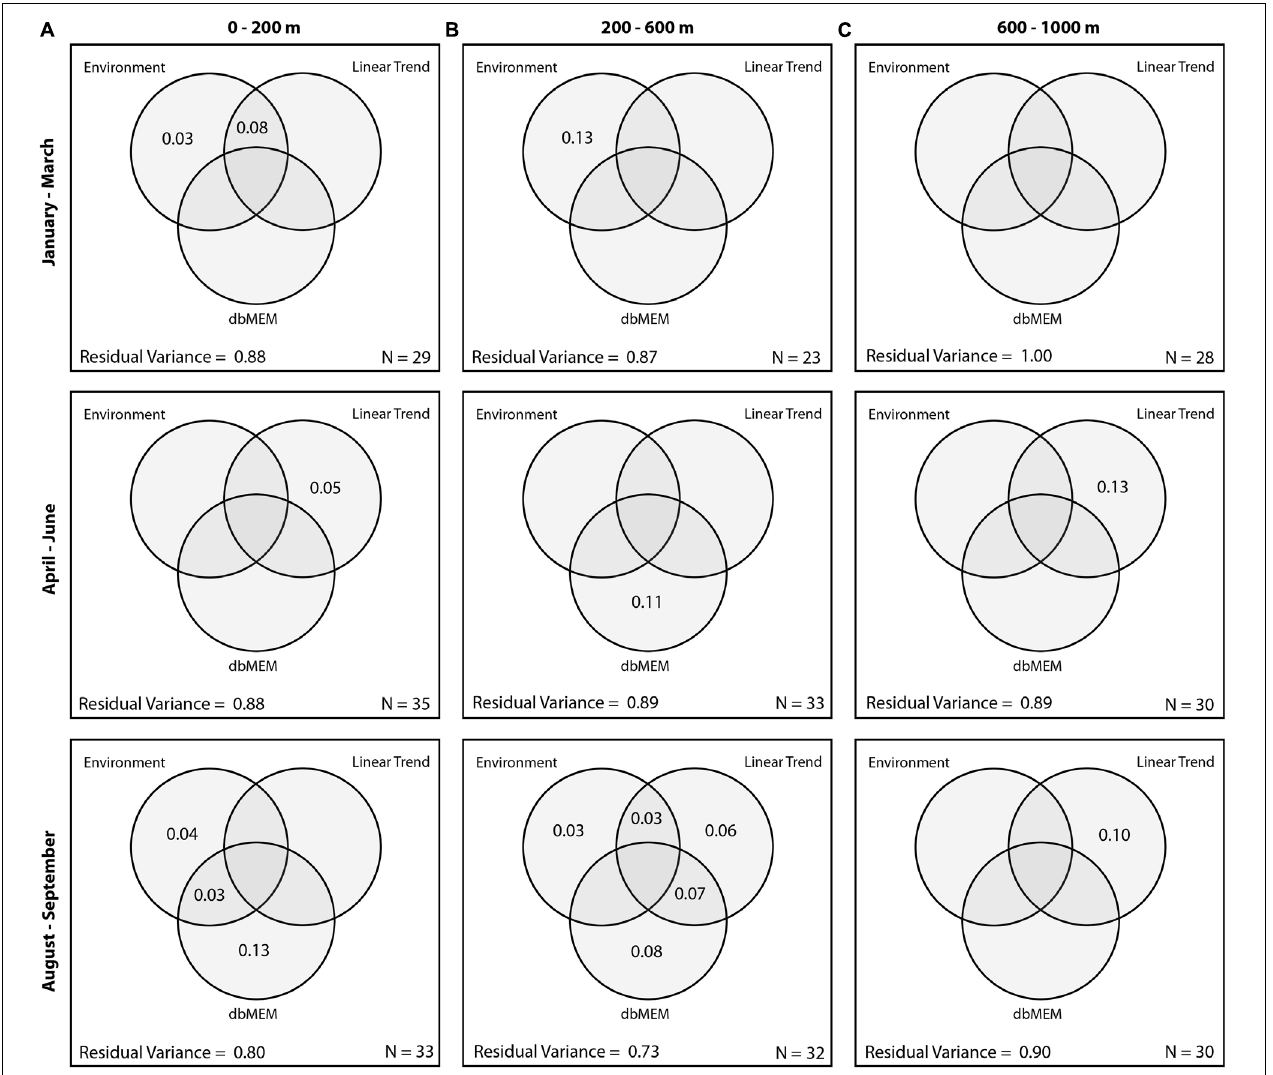
FIGURE 3 | Venn diagrams showing the relative variance explained by significant environmental and spatial variables at (A) 0–200 m (Night); (B) 200–600 m (Day); (C) 600–1000 m